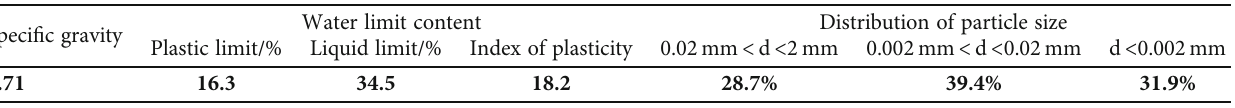
Figure 2: Studied area and location of soil sample. Table 1: Physical properties of soil